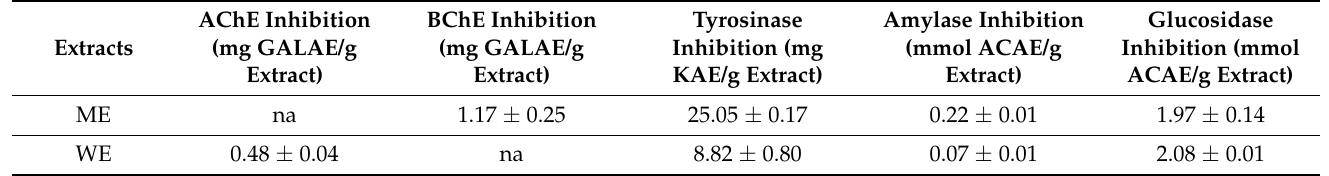
Table 3. Enzyme inhibitory effects of H. procumbens